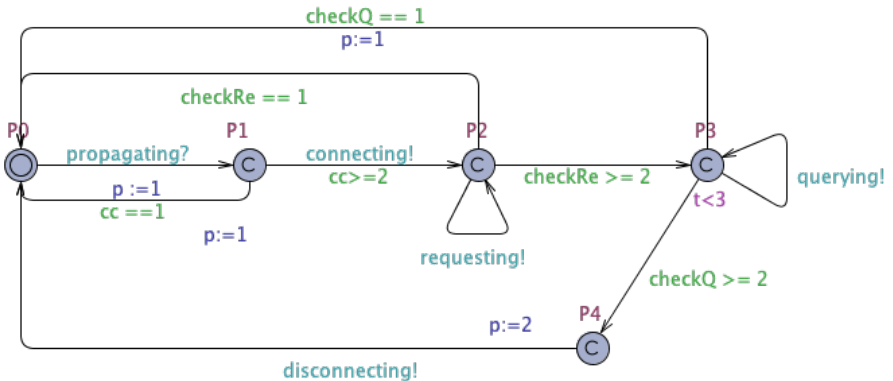
Figure 6. The block-propagation